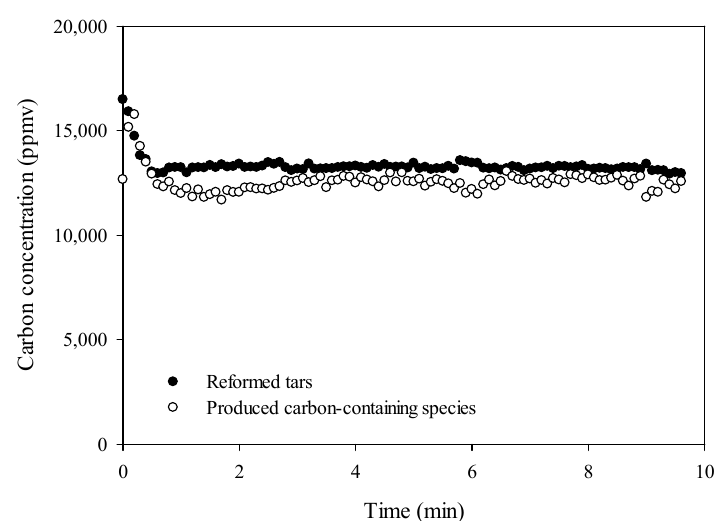
Figure 15. Carbon balance of toluene and naphthalene reforming over CaO at 850 °C. (Reformed toluene and naphthalene: 7 ∙ ((cid:1877) (cid:3004)(cid:2875)(cid:3009)(cid:2876),(cid:3036)(cid:3041) − (cid:1877) (cid:3004)(cid:2875)(cid:3009)(cid:2876),(cid:3042)(cid:3048)(cid:3047) ) + 10 ∙ ((cid:1877)